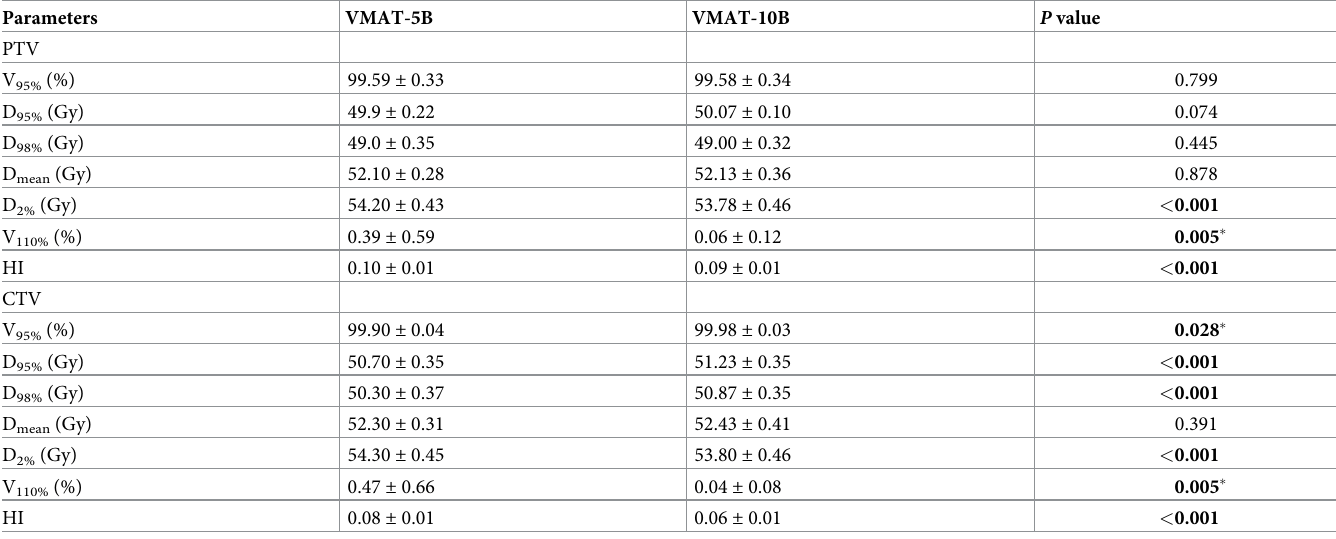
The values in bold indicate significant differences. � Significant differences with paired Wilcoxon signed-rank